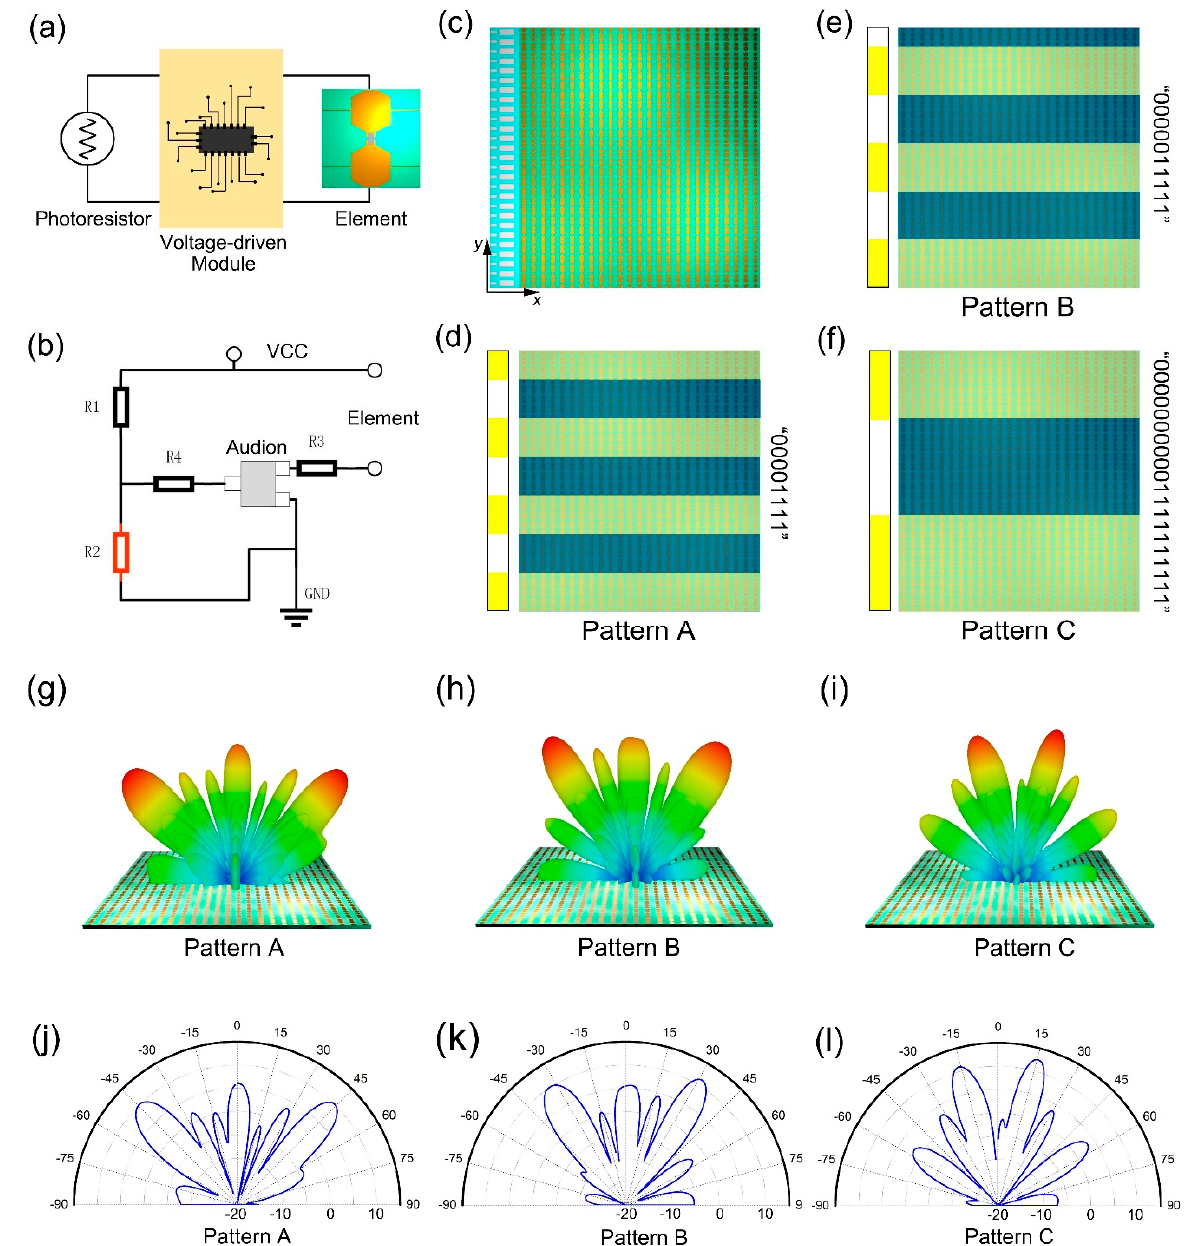
Figure 8. ( a ) Diagram of connection between photoresistor and element (from Figure 3a of Ref. [117]). ( b ) The voltage control circuit (from Figure 3b of Ref. [117]). ( c ) A schematic diagram of the metasurface consisting of 25 × 27 cells (from Figure 3c of Ref. [117]). The pattern with the coding sequence of ( d ) “00001111”, ( e ) “0000011111”, and ( f ) “00000000001111111111” (from Figure 3e,f of Ref. [117]). ( g , j ) The simulated far-field results pattern A. (from Figure 4a,b of Ref. [117]). ( h , k ) The simulated far-field results pattern B (from Figure 4c,d of Ref. [117]). ( i , l ) The simulated far-field results pattern C (from Figure 4e,f of Ref. [117]). Reproduced with permission from Ref. [117] under a Creative Commons Attribution 4.0 International License.